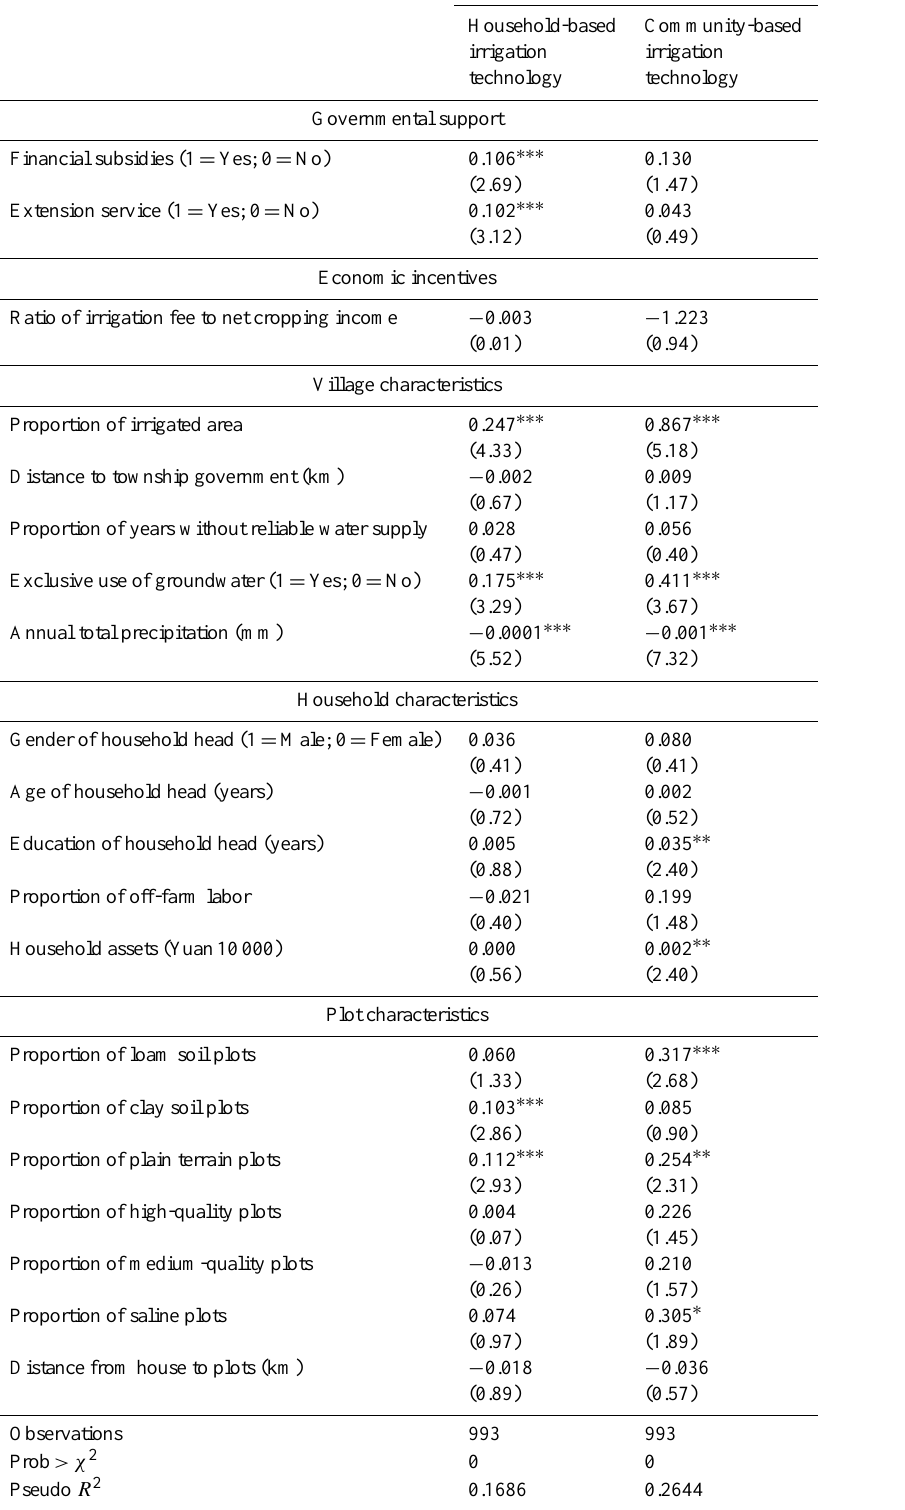
Table 6. Estimates of determinants of the adoption intensity of modern irrigation technology in China (Tobit